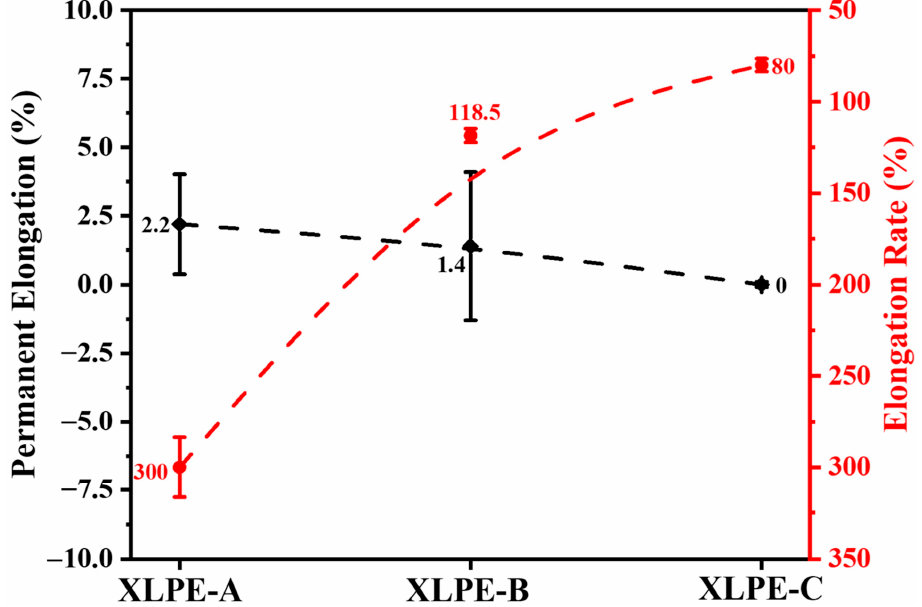
Figure 7. Identification of permanent elongation (%) and elongation rate (%) by hot-set test for XLPE prepared with DCP content of 1.4% (XLPE-A), 1.7% (XLPE-B) and 2% (XLPE-C). The electrical resistivity was measured under 10 kV/mm–60 kV/mm at 30–90 ◦